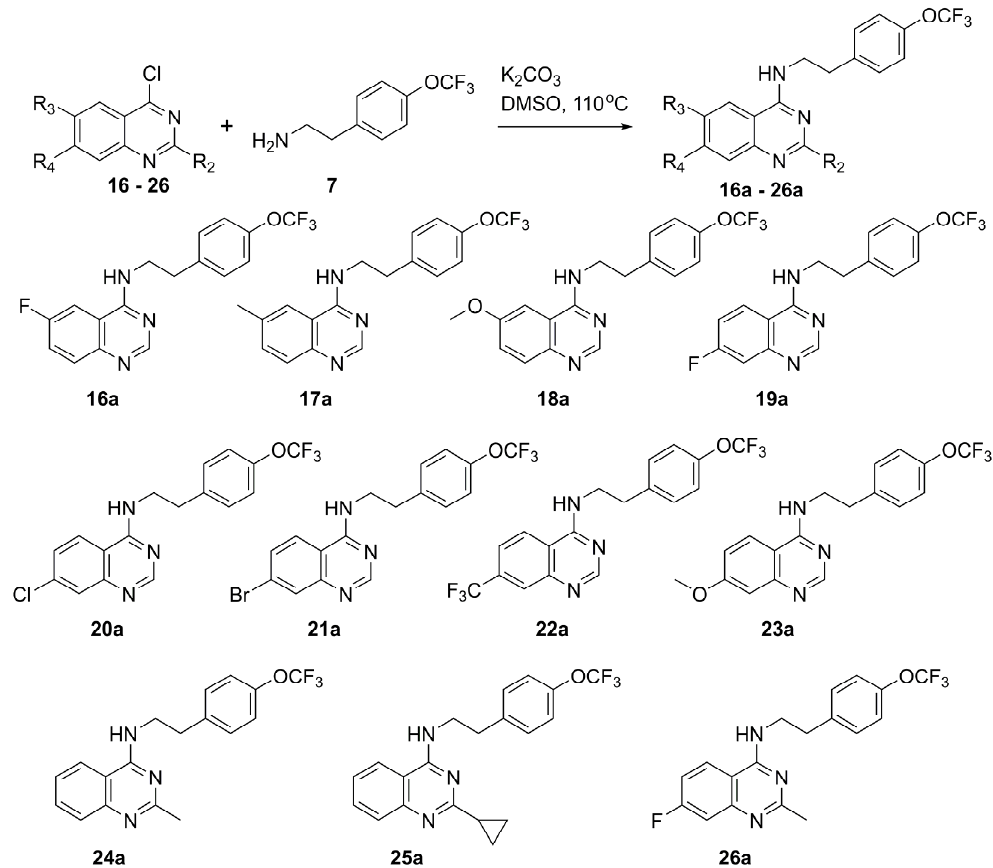
Table 2. Screening of the second set of N -phenethylquinazolin-4-amines 16a – 26a against cyt- bd of M. bovis BCG and M. tuberculosis H37Rv by ATP readout along with known inhibitors ND-11992 ( 2 ), aurachin D and bedaquiline (BDQ) as positive